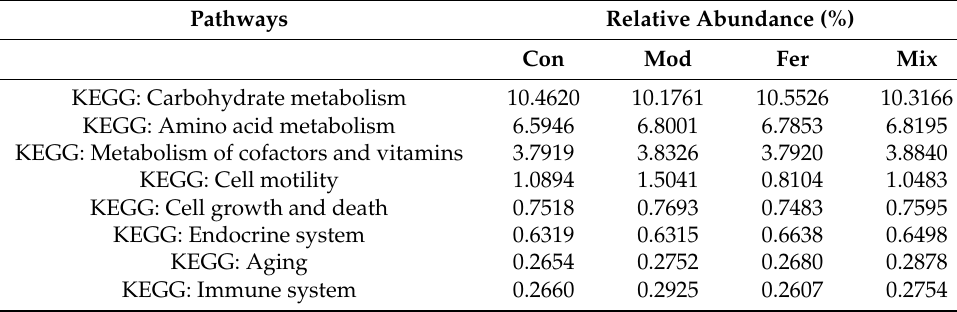
Table 3. Functional pathways of gut microbiota were altered by